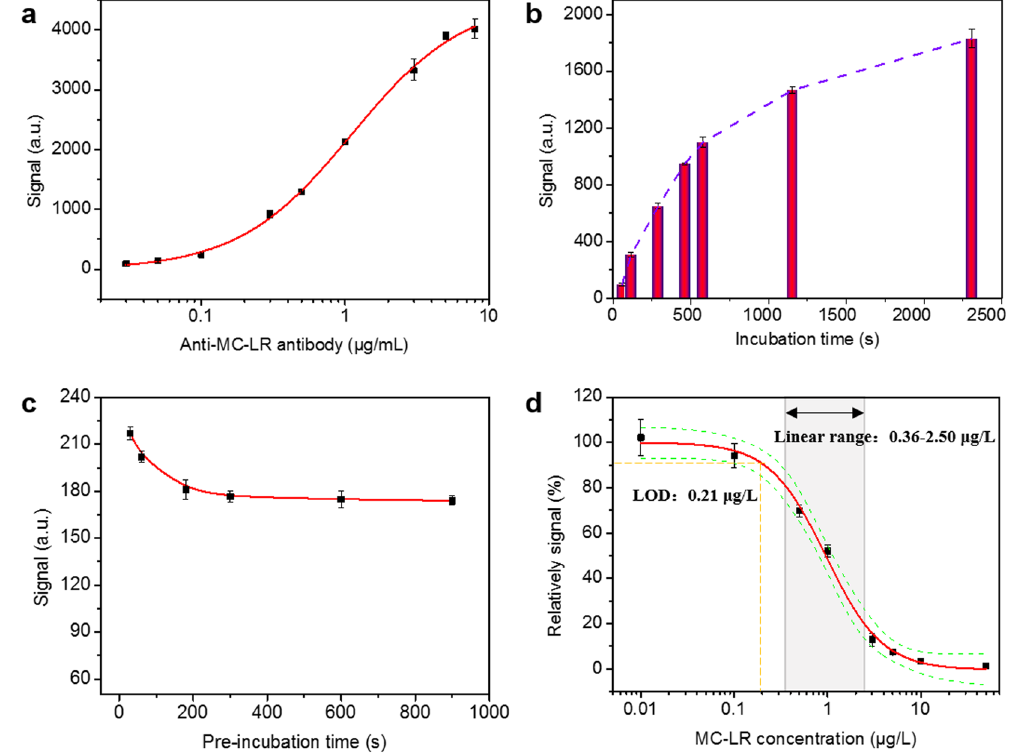
Figure 6. Relationships between ( a ) the Cy5.5-labeled MC-LR antibody concentration, ( b ) the incubation time, ( c ) the preincubation time and fluorescence signals, respectively; ( d ) Typical calibration curve in triple measurements (Green line represents 95% confidence range) for MC-LR by using the